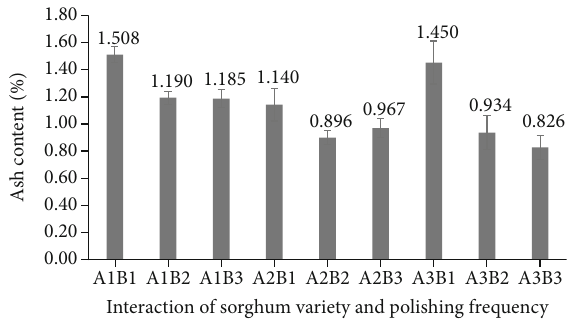
Figure 14: Ash content of three varieties of polished sorghum grains at di ff erent polishing